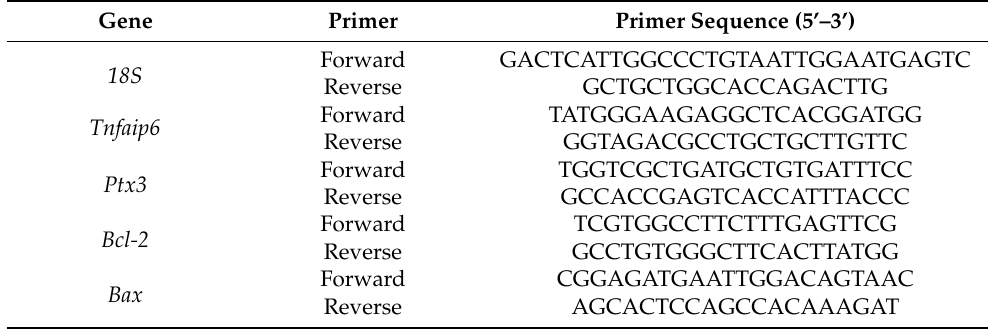
Table 1. Primers were used in this